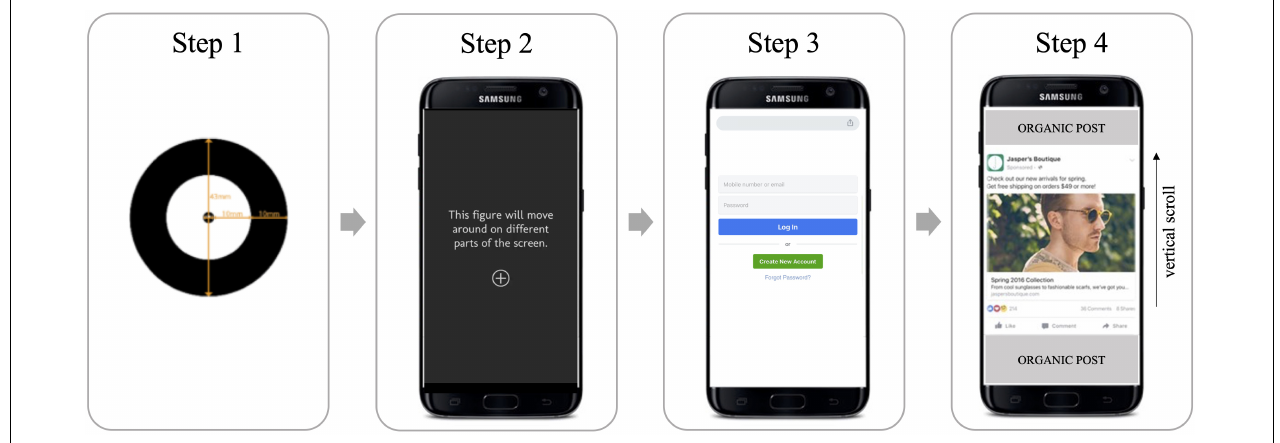
FIGURE 2 | An illustration of the participant study flow. Step 1 : The participant goes through an eye-tracking calibration scenario. Step 2 : The eye-tracking calibration is validated with a 5-point validation scenario presented on a smartphone screen. Step 3 : The participant logs in to their social media account and opens the main feed. Step 4 : The participant browses their feed in a self-paced session, where the ads have been inserted every 5th